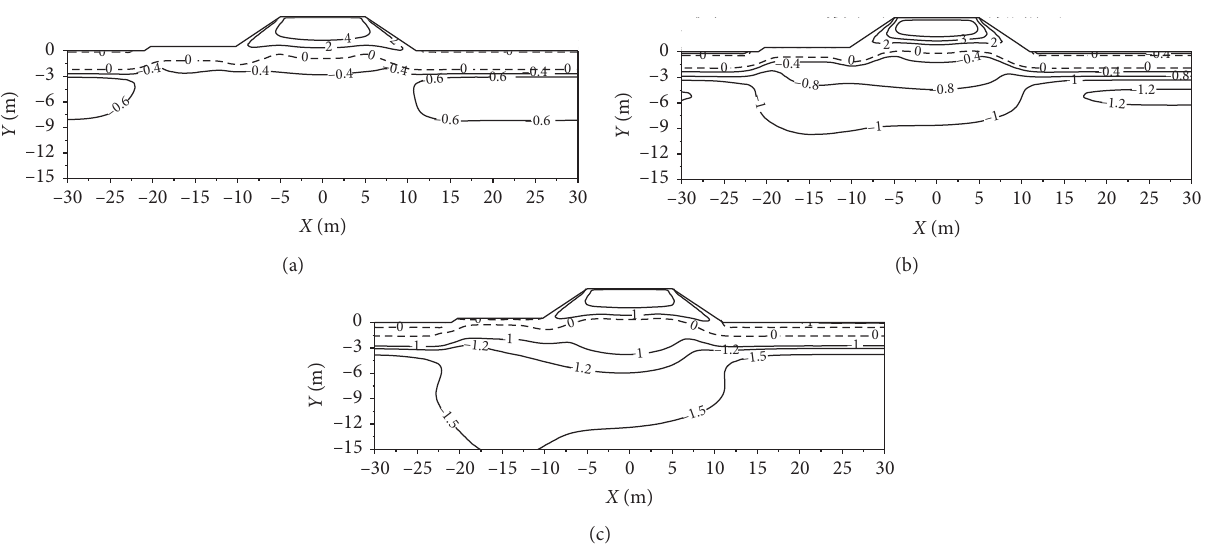
Figure 6: Distribution of the temperature field beneath the SE in October of the 5th year under the different mean annual ground temperatures: (a) − 0.5 ° C, (b) − 1.0 ° C, and (c) − 1.5 ° C (unit: ° C).